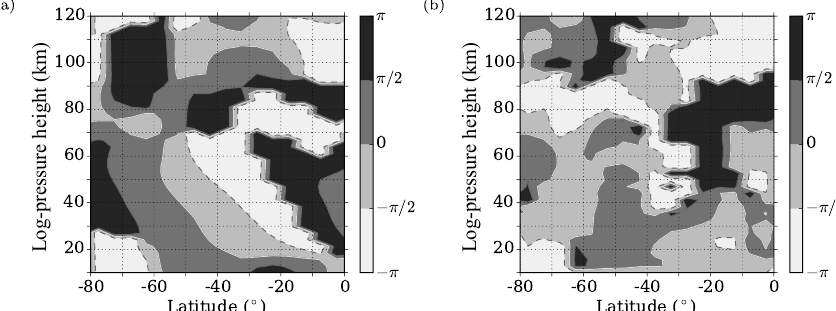
Figure 11. Run1 zonal wind SPW1 phases, SPW forcing only through lower boundary fields (a) . Run 3 zonal GW acceleration SPW1 phases, SPW forcing only through non-zonal 2-D GW distribution (b)